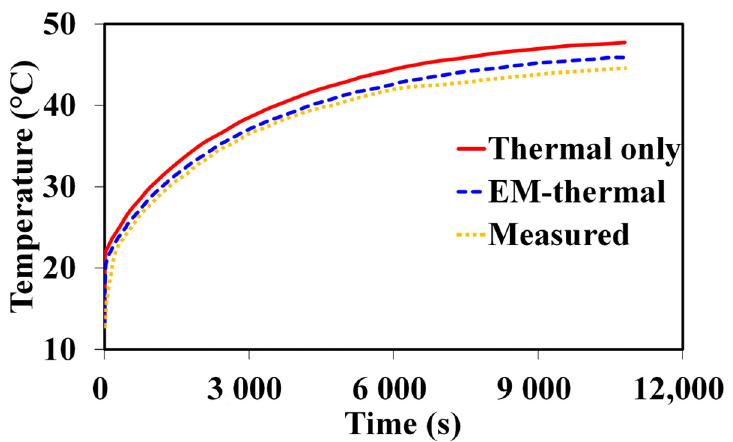
Figure 19. Comparison of transient temperature rise in SC turns (300 r/min, 3 A).